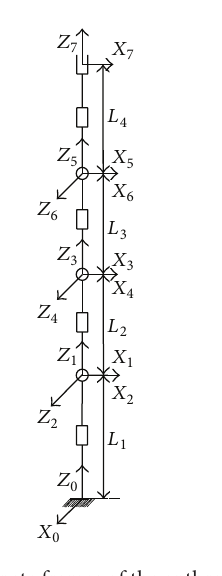
Figure 2: D-H coordinate frames of the anthropomorphic arm.